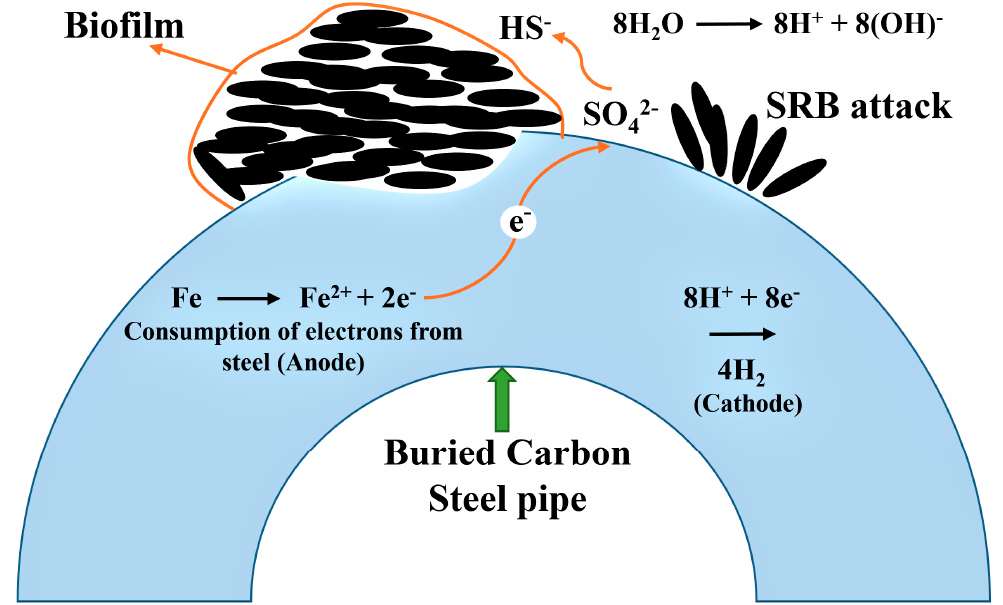
Figure 1. A schematic view of the function of sulfate-reducing bacteria (SRB) in microbiologically induced corrosion (MIC).